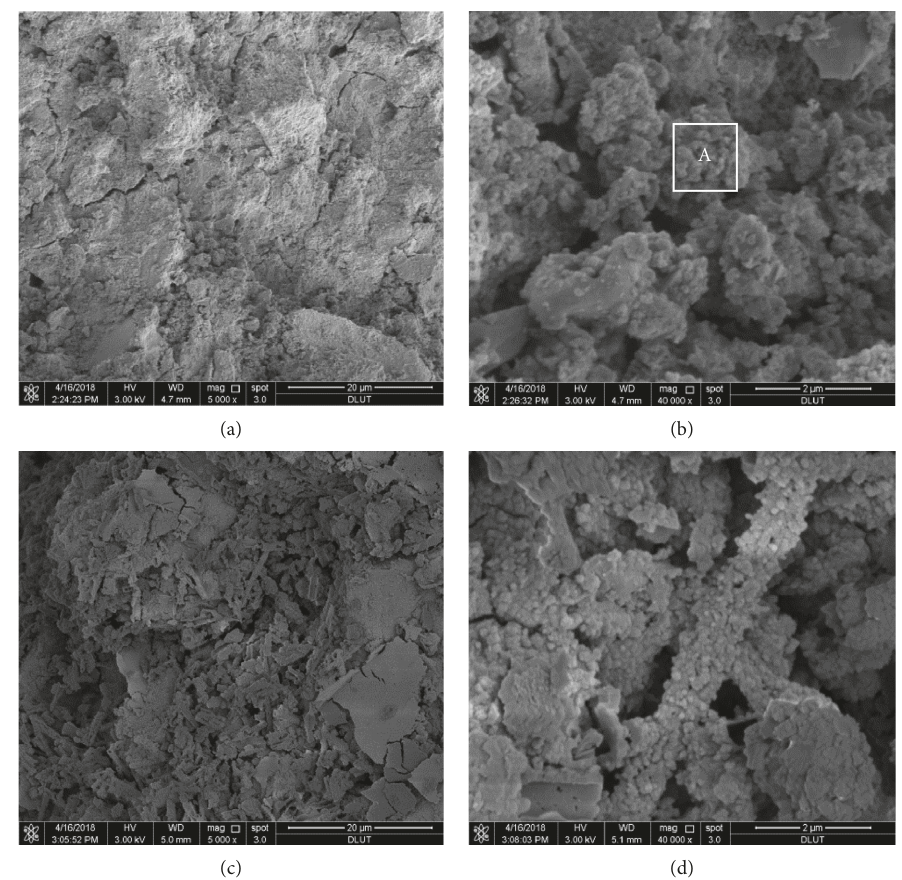
Figure 10: SEM micrographs of the copper-nickel slag and CNSCMs cured for 28(d). (a, b) Copper-nickel slag cementing materials cured with 70% humidity and (c, d) copper-nickel slag cementing materials cured with 40% humidity. Table 4: Composition of CNSCM by SEM-EDS.